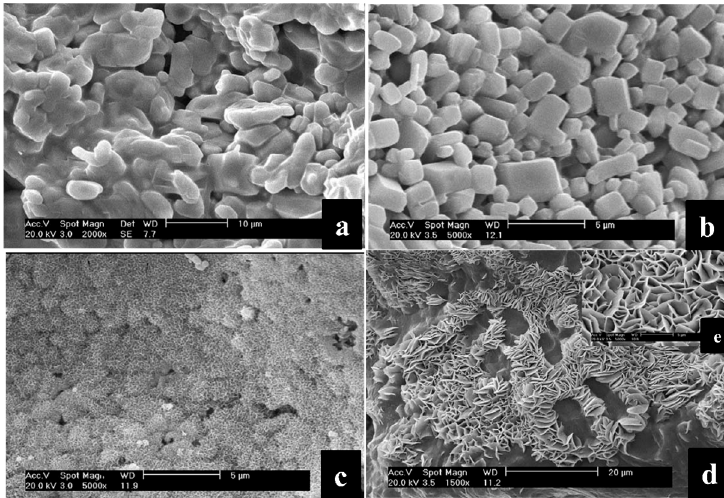
Figure 4. SEM micrographs of ( a ) glass-ceramics of the CaO–P 2 O 5 –Na 2 O–SrO–ZnO system sintered at 650 ◦ C for 4 h, ( b ) the samples after treatment by HCl solution at pH 1.0 for 2.5 min, ( c ) pH 3.0 for 2.5 min, ( d ) pH 10.0 for 2.5 min, and ( e ) pH 10.0 for 10.0 min. Reproduced with permission from Reference